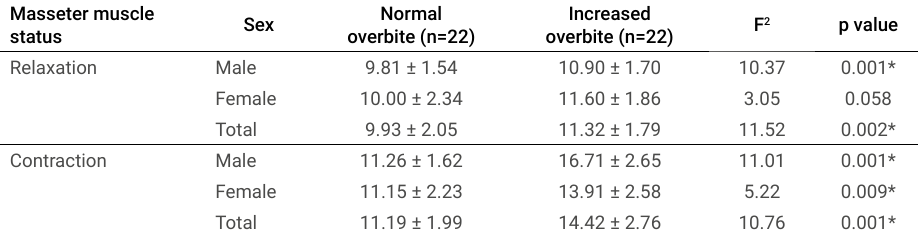
Table 4. Two-way ANOVA of muscle thickness in relation to occlusal vertical dimensions (overbite) Masseter muscle status